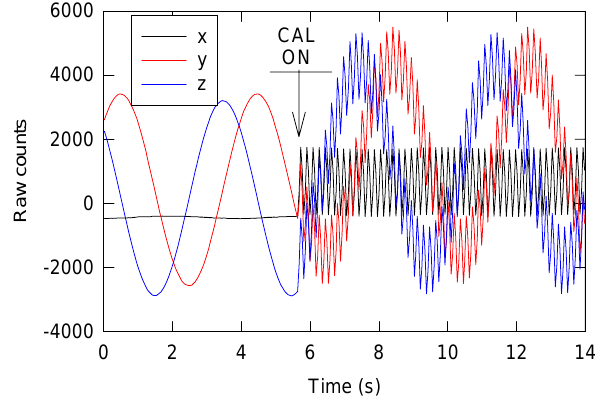
Fig. 4. Implementation of the in-flight calibration mode of the FGM instrument. The data illustrated are from an actual calibration se- quence on spacecraft 1. When the calibration mode is switched on, a train of square wave, consisting of 512 on-off applications of a fixed value calibration signal is internally superposed on the ambi- ent field measured by the instrument. The frequency of the square wave is matched to the filtering bandwidth of the vector